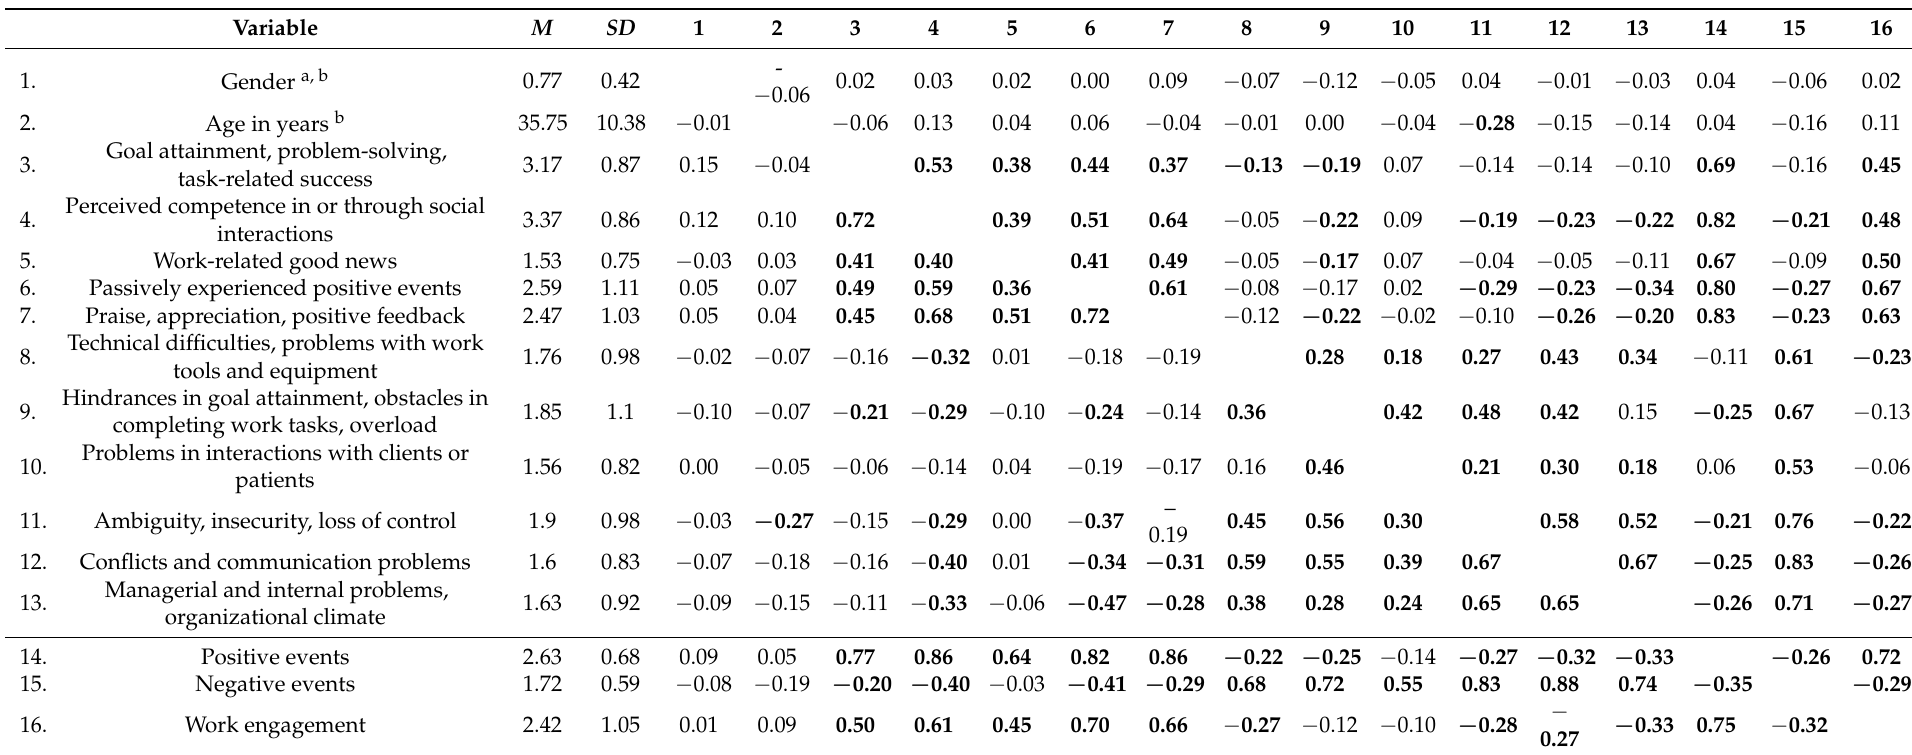
Table 2. Means, Standard Deviations, and Correlations Among Study Variables at the Interindividual